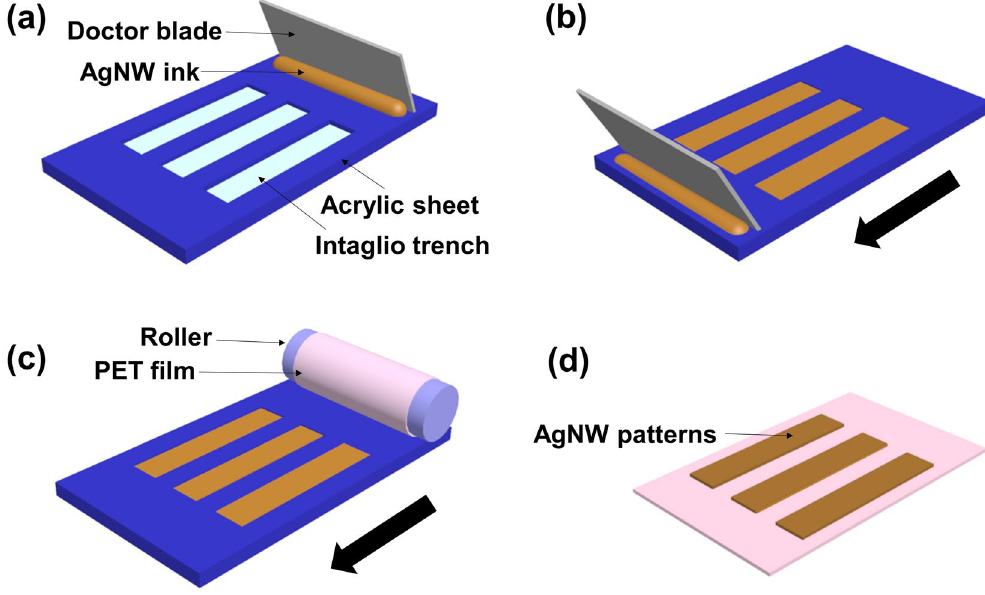
Figure 2. Schematic illusion of the inverse direct gravure printing